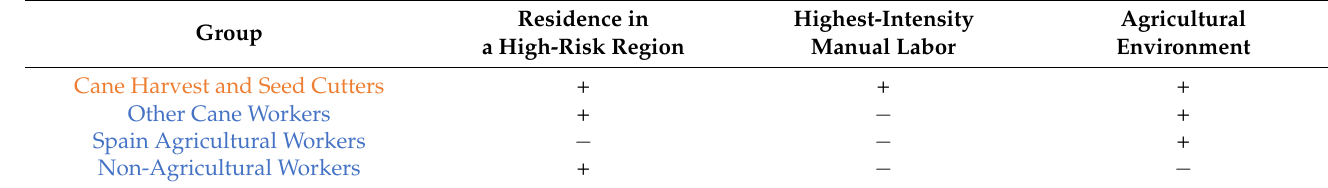
Table 1. Population-level pre-specified risk factor exposure assumptions. Groups hypothesized to have greater risk for subsequent development of Mesoamerican nephropathy are in orange, and those with less likelihood are in blue. “+” indicates a high association with each risk factor, “ − ” indicates a lower association with each risk factor. Residence in Highest-Intensity Agricultural Group a High-Risk Region Manual Labor